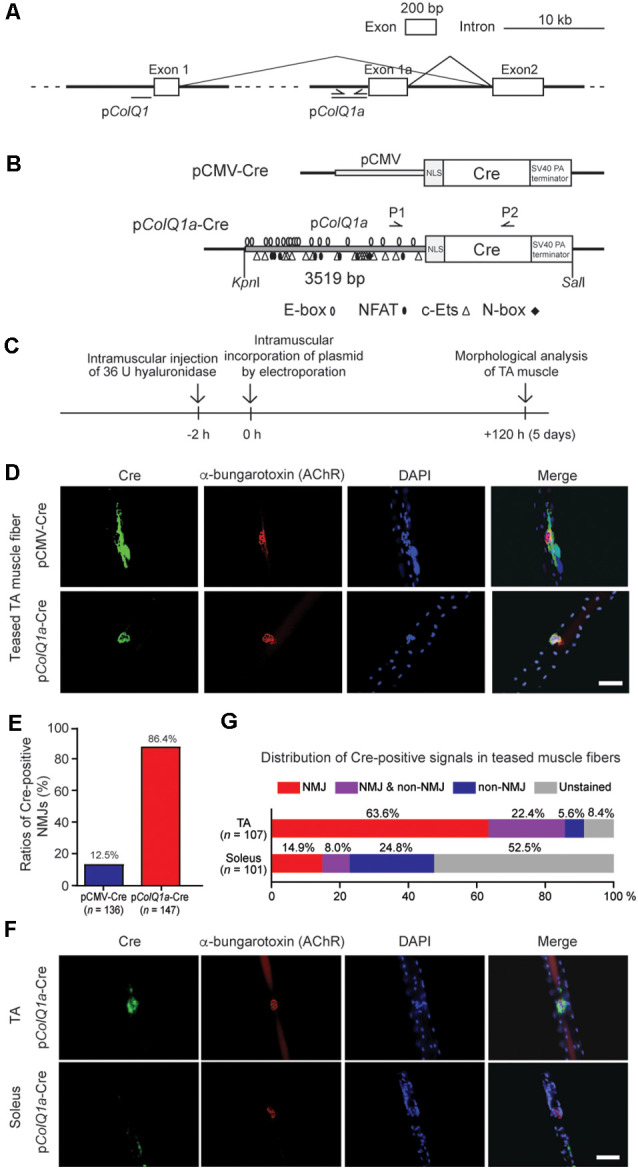
Mouse pColQ1a promoter expresses Cre at the neuromuscular junction (NMJ) of the tibialis anterior (TA) muscle. (A) Mouse Colq is driven by two distinct promoters. pColQ1 drives transcription from exon 1, whereas pColQ1a drives transcription from exon 1a. PCR primers (Supplementary Table S1) to amplify a 3519-bp fragment of pColQ1a are indicated by arrows. (B) Schematic of pCMV-Cre and pColQ1a-Cre. pCMV or pColQ1a was fused to the nuclear localization signal (NLS) sequence and the Cre recombinase gene. P1 and P2 arrows indicate the positions of genotyping primers. Putative binding motifs of transcription factors (E-box, NFAT, c-Ets, and N-box) are indicated (Lee et al., 2004). (C) The protocol of muscle electroporation. (D) Representative immunostaining of Cre (green) and Alexa594-conjugated α-bungarotoxin-staining for AChR (red) of teased TA muscle fibers at 5 days after electroporation of the indicated plasmids. The nuclei were stained with DAPI. Scale bar = 30 μm. (E) Ratios of Cre-positive NMJs in teased TA muscle fibers electroporated with pCMV-Cre and pColQ1a-Cre in 4 pCMV-Cre mice (n = 136 fibers, respectively) and 5 pColQ1a-Cre mice (n = 147 fibers). P < 0.001 by Fisher’s exact test (see Supplementary Table S3 for individual counts). (F) Representative images showing NMJ-specific expression of Cre in teased TA muscle fibers but not in teased soleus muscle fibers of the pColQ1a-Cre mouse. Teased muscle fibers were stained with anti-Cre antibody (green) and Alexa594-conjugated α-bungarotoxin 594 (red). Nuclei were stained with DAPI. Scale bar = 30 μm. (G) Distribution of Cre-positive signals along teased muscle fibers of TA and soleus muscles of the pColQ1a-Cre mouse. The total number of teased muscle fibers is shown in parentheses. P < 0.001 by Fisher’s exact test (see Supplementary Table S4 for individual counts).